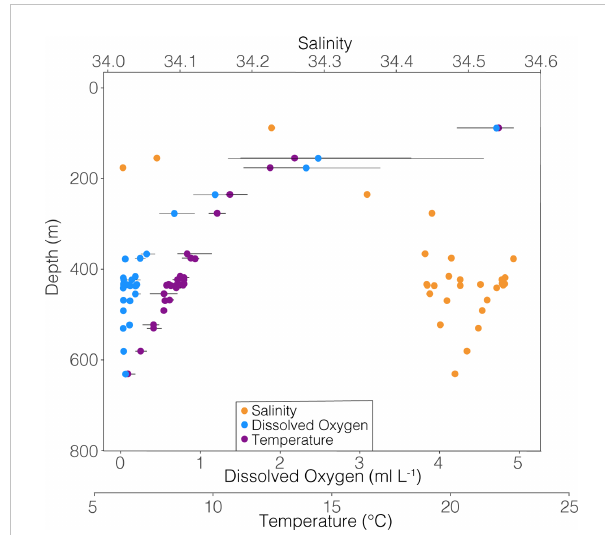
FIGURE 1 Temperature, salinity, and dissolved oxygen relative to depth of all samples from which G. hexagonus was picked. Points represent the mean, and horizontal bars extend to the minimum and maximum value measured in each net since it is not known where within a particular net an individual foraminiferan was collected. Data represent results from nine tows. Thus hydrographic variables taken together represent an aggregate rather than an instantaneous pro fi le of conditions within the water